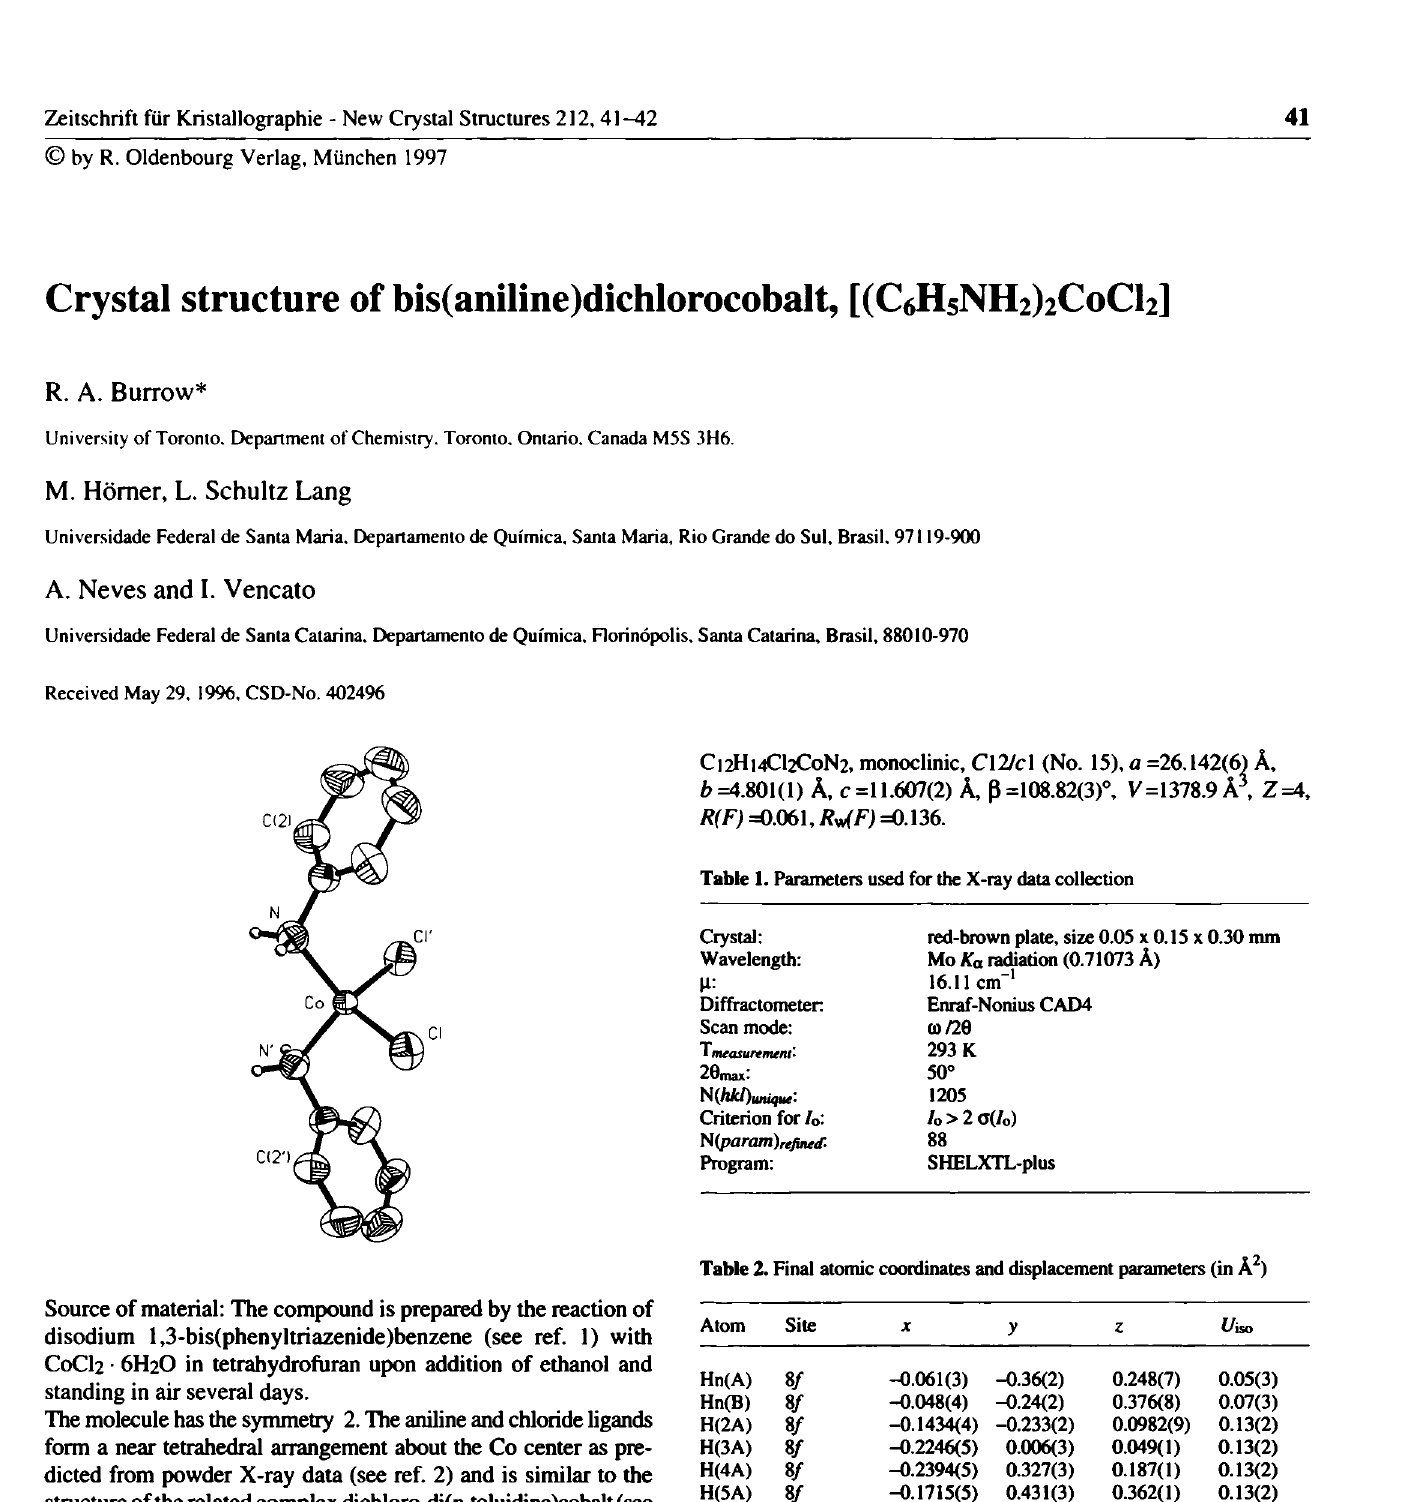
Table 2. Final atomic coordinates and displacement parameters (in A 2